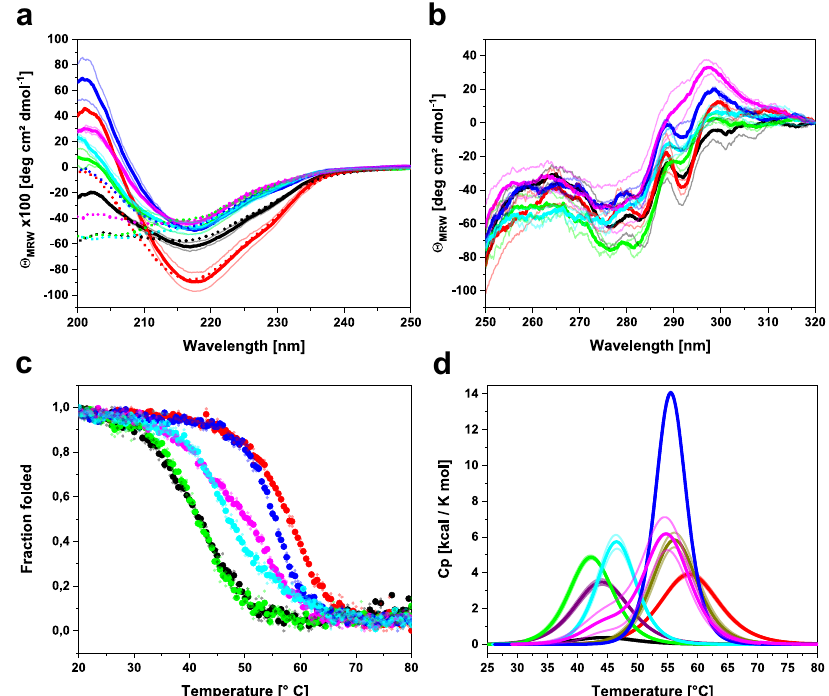
Fig. 2 Structural properties and thermodynamic stability of FOR005 variants. a FUV-CD spectra of the native (solid lines) and refolded (dotted lines) proteins indicating secondary structure. The mean of two measurements is shown as thick lines, and the spectra of individual replicates are shown as thin lines with weaker coloring. Color code: P-CL in black, G-CL in red, P-LC in green, G-LC in blue, P-LC G136V in cyan, G-LC V136G in magenta. b NUV-CD spectra of the native proteins representing tertiary structure fi ngerprints. Coloring as in ( a ). c Normalized thermal unfolding transitions followed by CD at 205 nm. The transition midpoint T m indicates the melting temperature at which 50% of the protein is unfolded. Mean values are shown as thick dots and individual data points as smaller dots with light coloring. d Thermograms obtained by DSC. For comparison, the P-VL (purple) and G-VL (olive) were also included. Mean curves are shown as thick lines, individual measurements are shown as thin lines with weak coloring. All data are derived from two independent measurements ( n = 2), except for the refolded FUV-CD spectra after thermal unfolding (dotted lines in panel ( a )) which were only measured once. Source data are given in the Supplementary Data fi